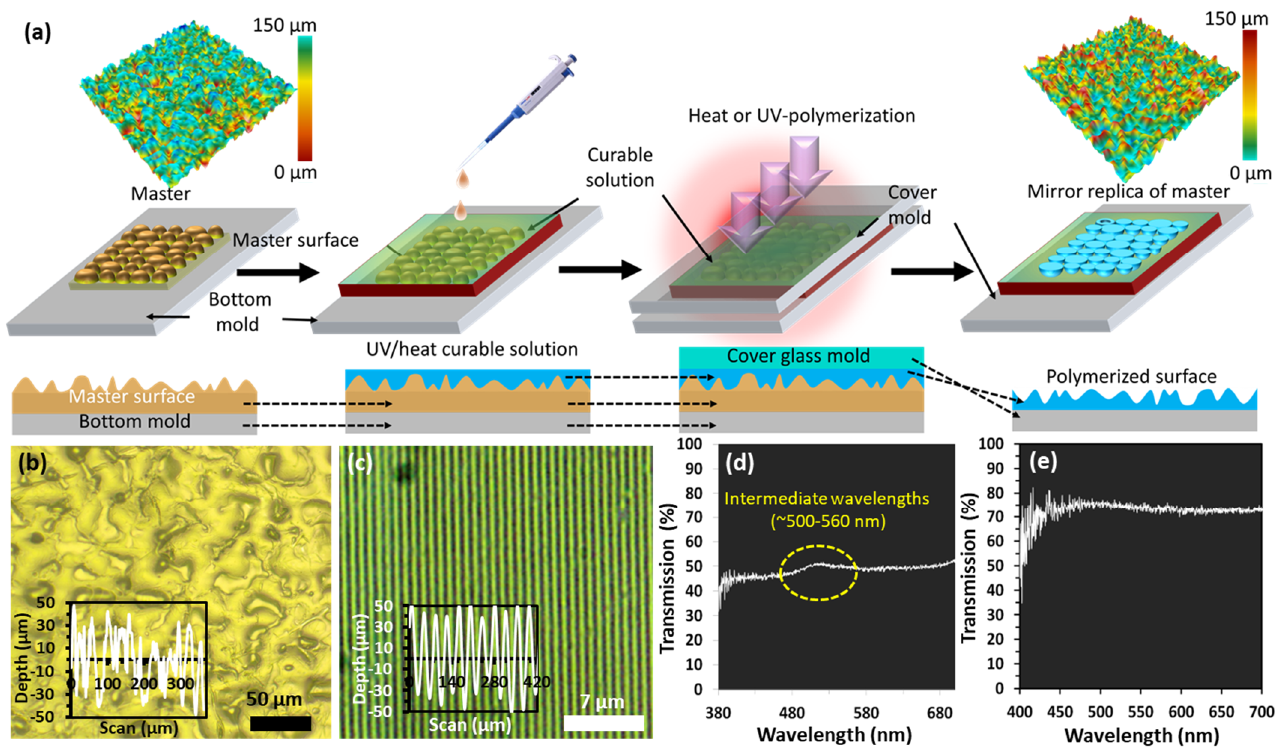
Figure 1. Micro/nano fabrication process (mirror replication) of selected master patterns on PDMS: ( a ) schematic representation of transferring rigid structures (micro/nanostructures) onto flexible substrates; ( b , c ) optical images representing morphological surface analysis of the polymerized flexible optical diffuser and diffractive grating surfaces, respectively; optical transmission spectra of replicated ( d ) flexible optical diffuser and ( e ) diffractive grating surface in the wavelength range of (380–700 nm) using a broadband (white light) source.